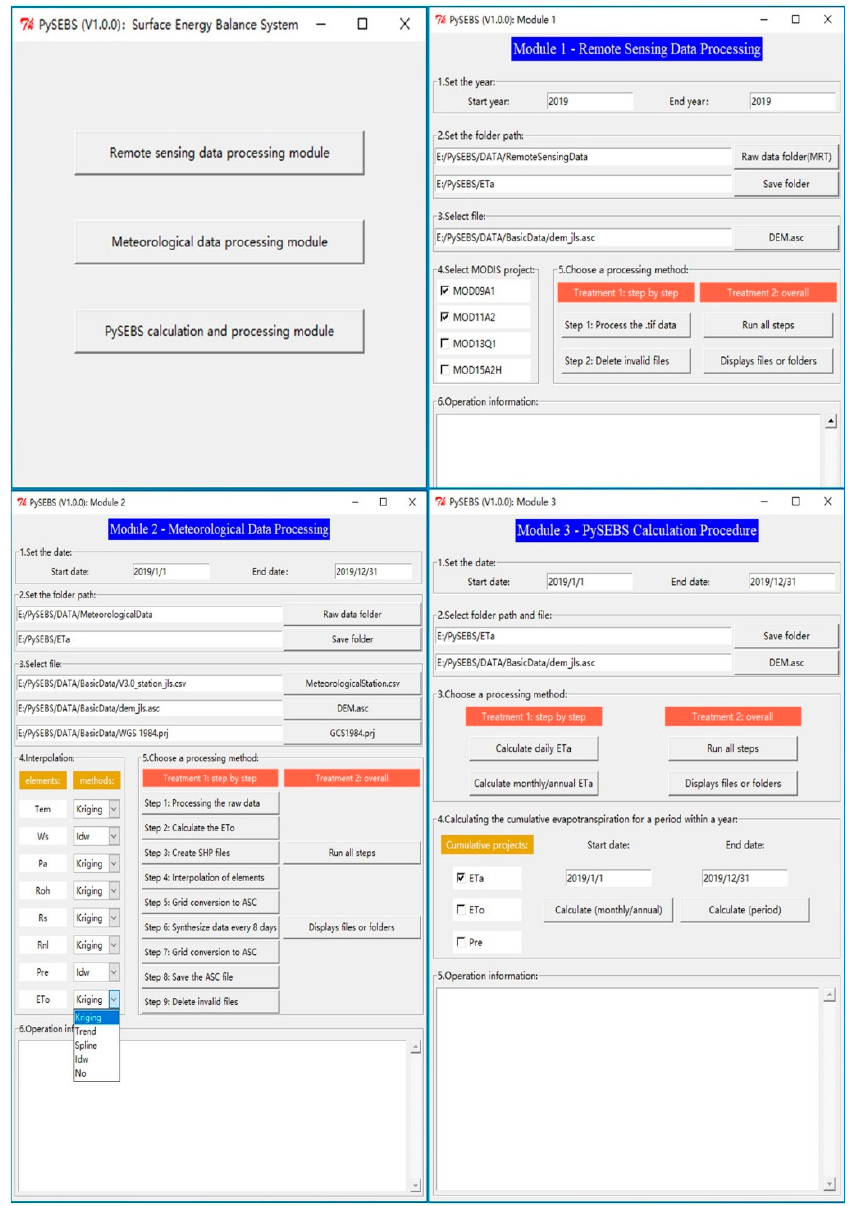
Figure 2. Graphical user interface of PySEBS software. The upper left part is the main menu, the upper right part is the module 1-remote sensing data processing; the lower left part is the module 2-meteorological data processing; and the lower right part is the module 3-PySEBS calculation and processing.